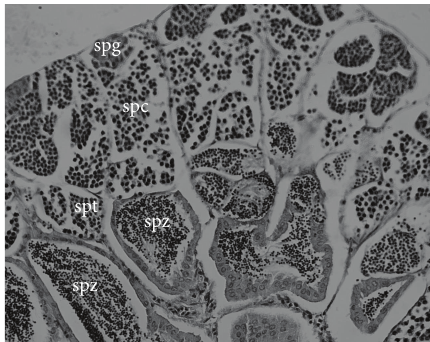
Figure 5: Histological aspects of spermatocyte development stages of H. brasiliensis : spermatocyte (spc), spermatid (spt); spermato- zoon (spz) (scale bar = 50 𝜇